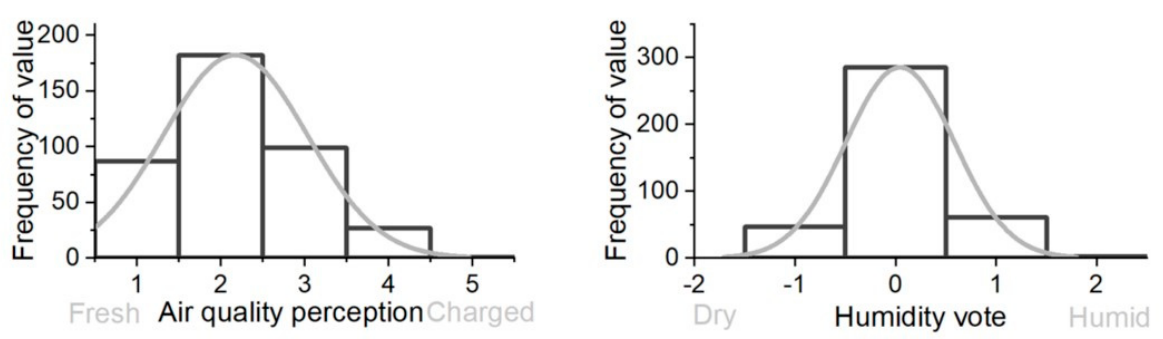
Figure 5. Perception votes for air quality and humidity .